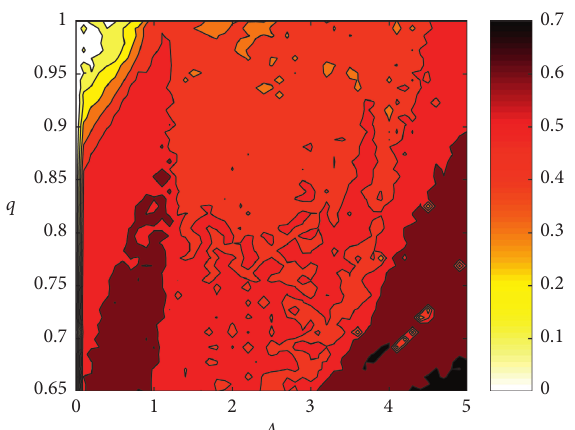
Figure 8: Chaos diagrams of fractional-order chaotic system (1): q - A plane.